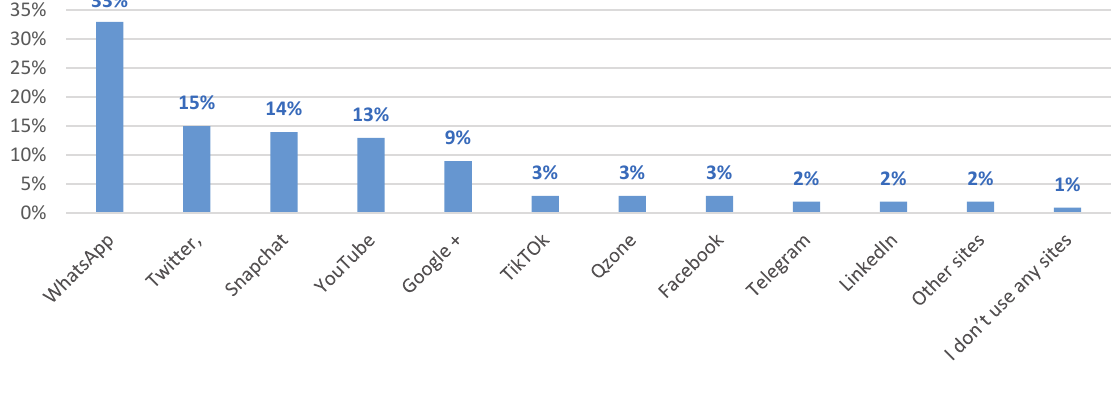
Fig. 2. The regularly usage of the